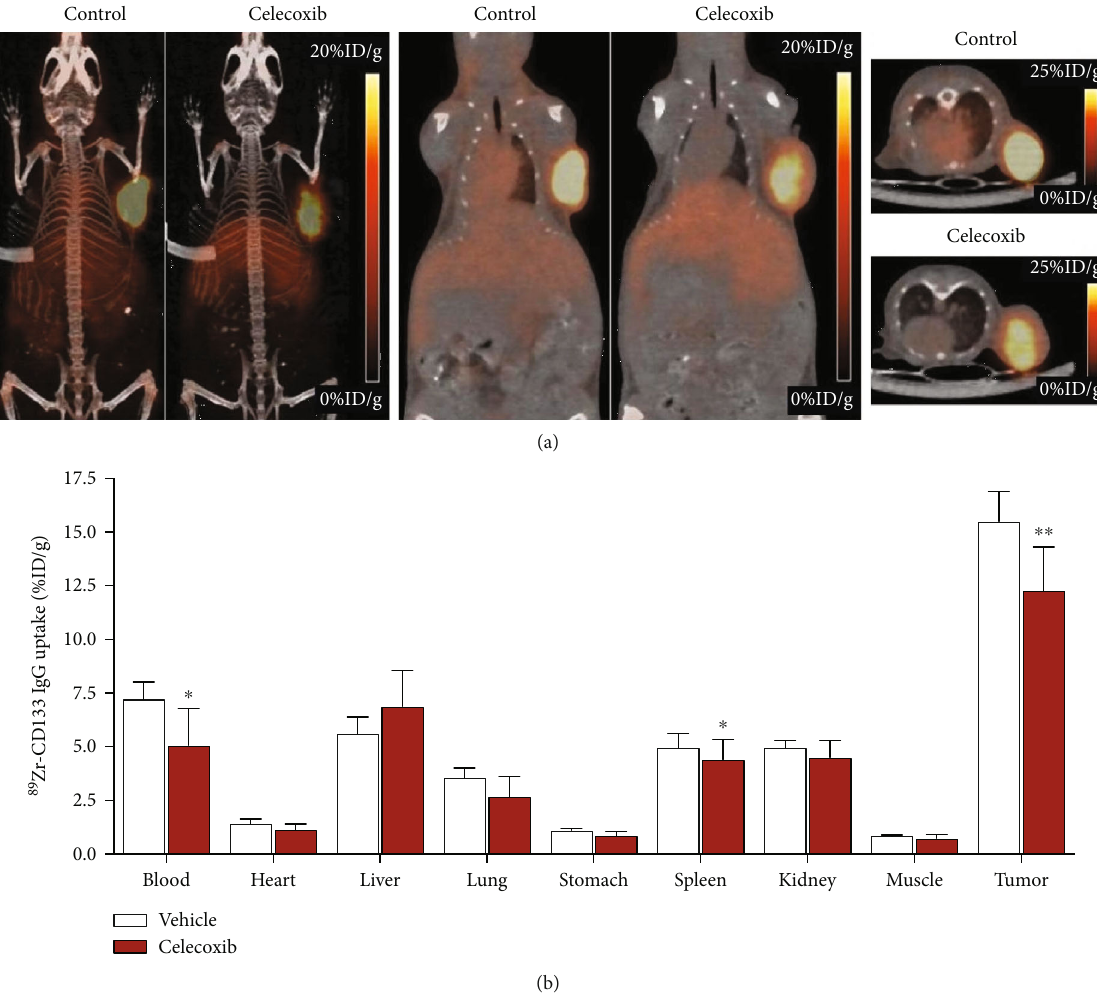
Figure 5: E ff ect of celecoxib on tumor uptake of 89 Zr-CD133 IgG. (a) Representative maximal intensity projection (left) and coronal (middle) and transaxial (right) PET images in HT29 tumor-bearing mice following intraperitoneal injection of 40 mg/kg celecoxib or vehicle (control) every two days for a total of eight times. 89 Zr-CD133 IgG was injected on the day of the seventh celecoxib treatment. (b) Biodistribution of 89 Zr-CD133 IgG in tumor-bearing mice treated as above. Bars are mean ± SD of %ID/g obtained from fi ve animals per group. ∗ P < 0 : 05 , ∗∗ P < 0 : 01 , compared to